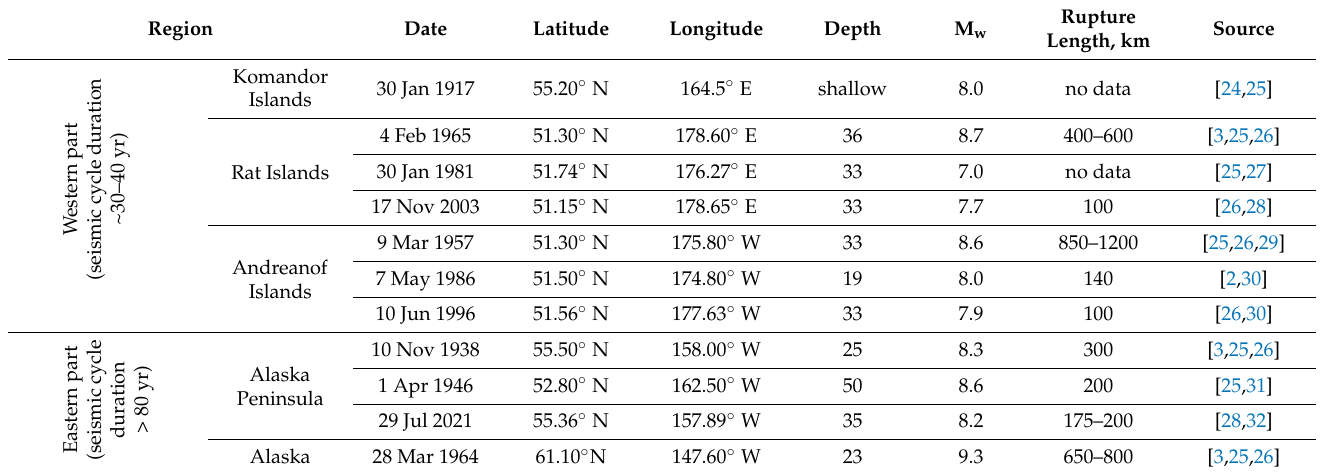
Table 1. Largest megathrust earthquakes in the Komandor-Aleutian subduction